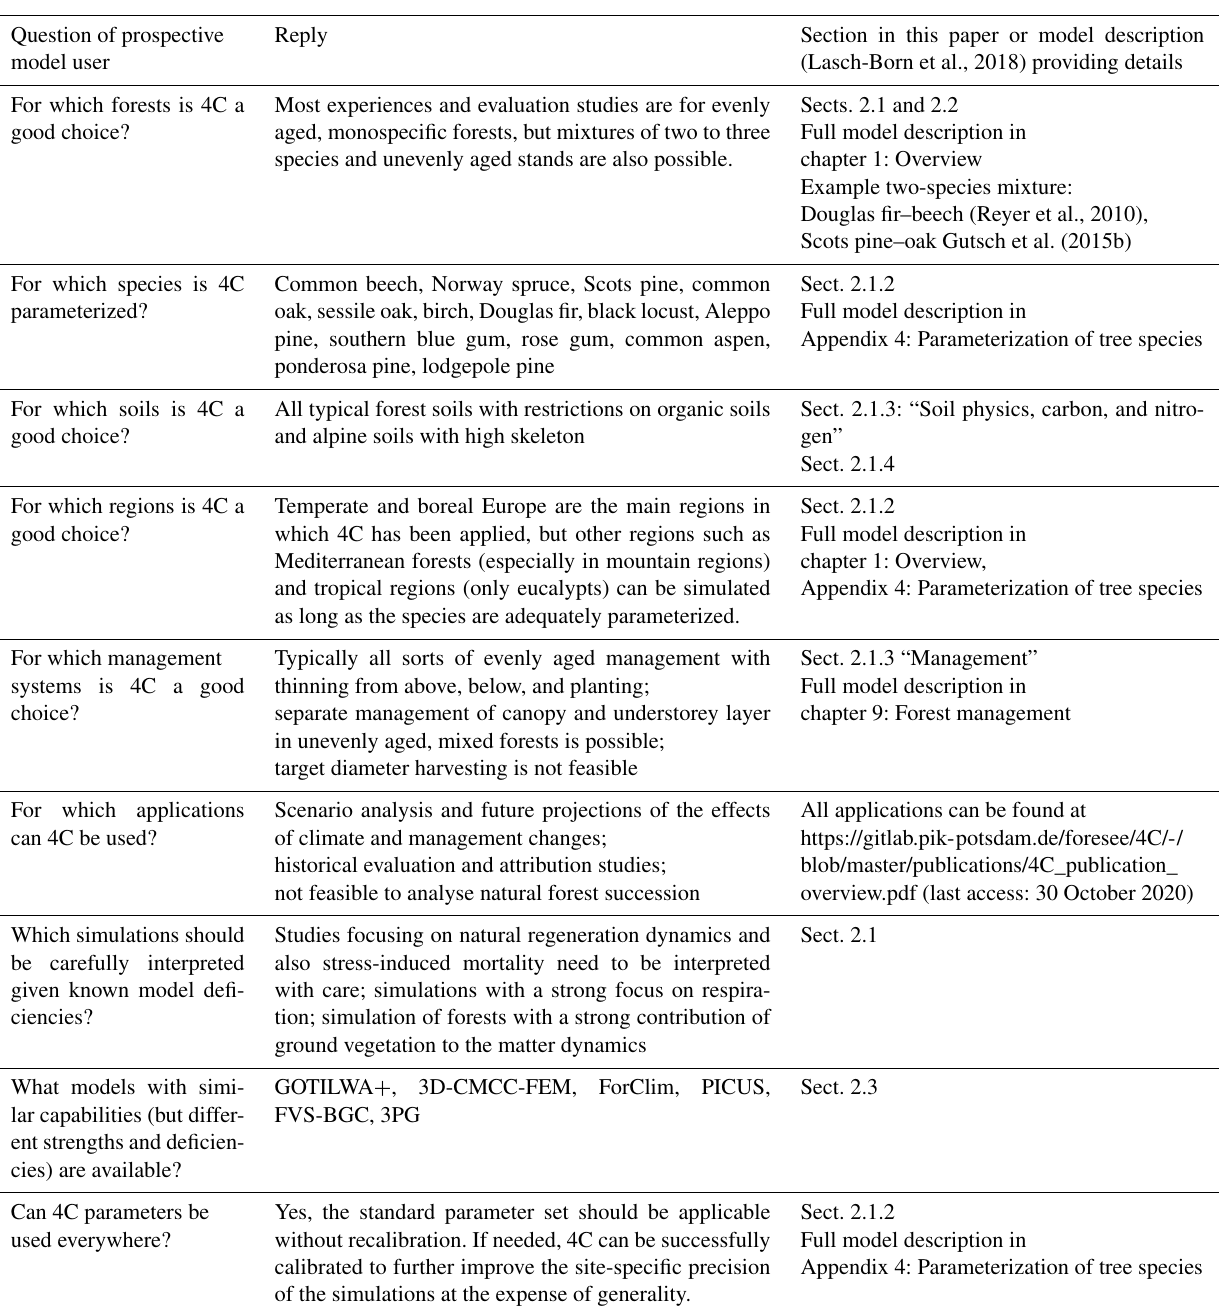
Table 7. Frequently asked questions (FAQs) for prospective scientific users of 4C. Question of